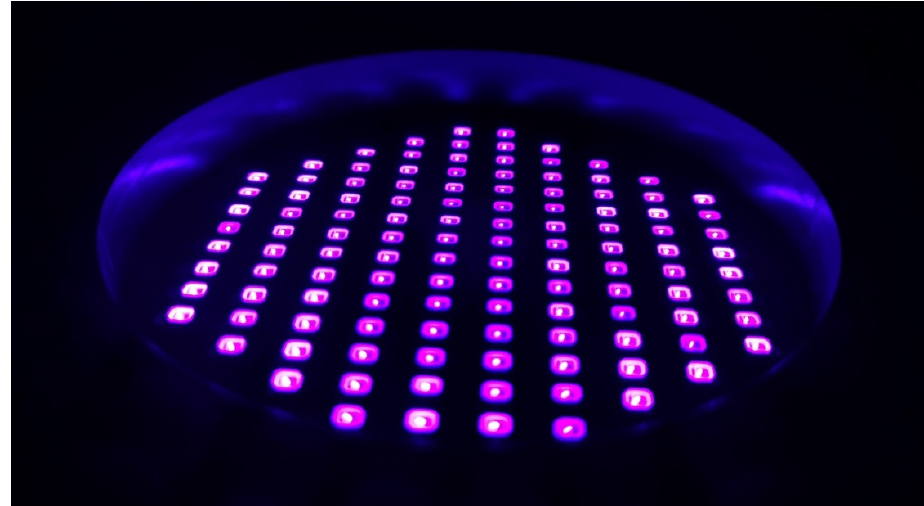
Figure 2. UV LED (light-emitting diodes). Author’s photo.